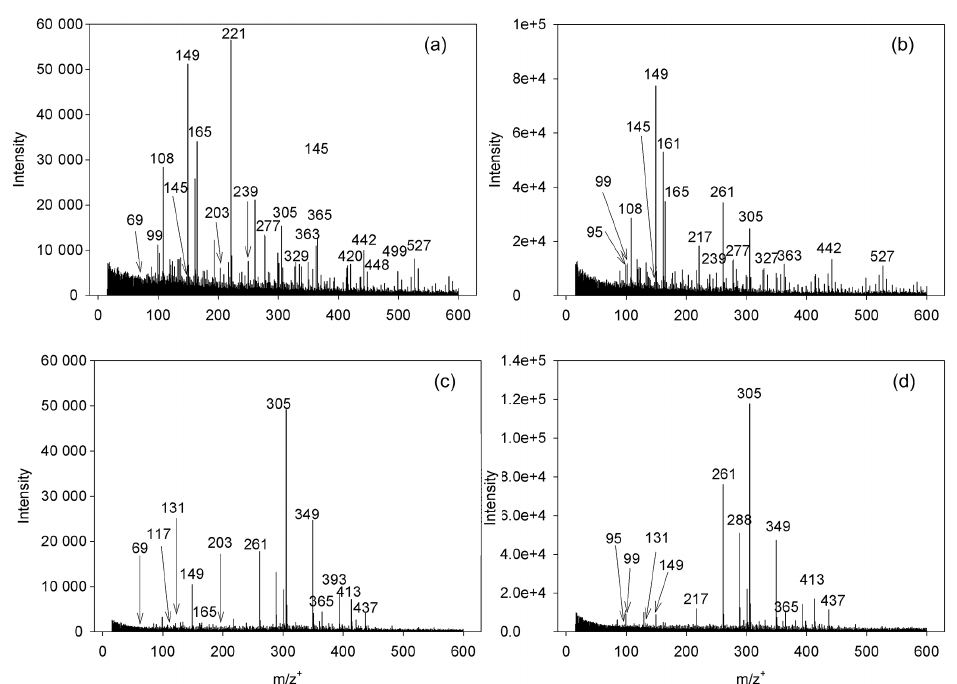
Figure 4. Positive-mode mass spectra for 3h irradiated AS aerosols (a) and SA aerosols (b) in the humid chamber, and AS aerosols (c) and SA aerosols (d) in the dry